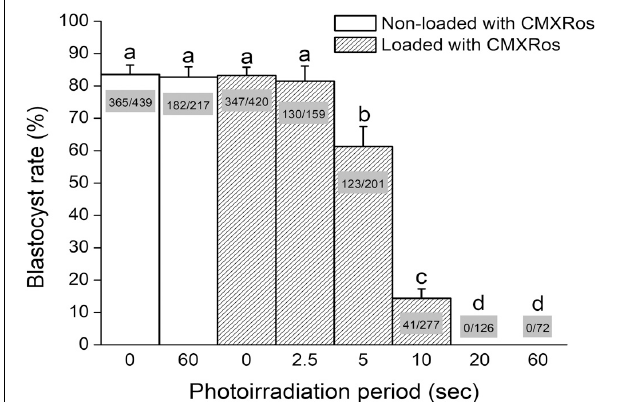
FIGURE 1 | Photoirradiation of CMXRos-loaded zygotes prevents development into blastocysts. Percentage of NZB zygotes that developed into blastocysts after 96 h of in vitro culture. Zygotes were either loaded or not with CMXRos prior to photoirradiation. Bar insets represent the number of blastocysts in relation to total number of cultured zygotes. Different letters over bars depict statistical difference ( P <